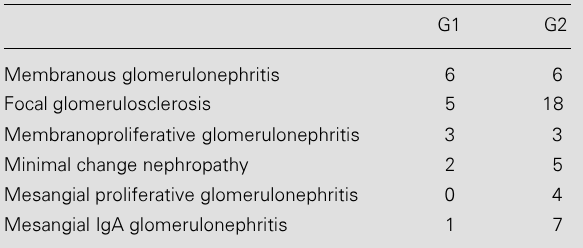
Table 2 - Histological diagnosis of patients with (G1) and without (G2) glycosuria.